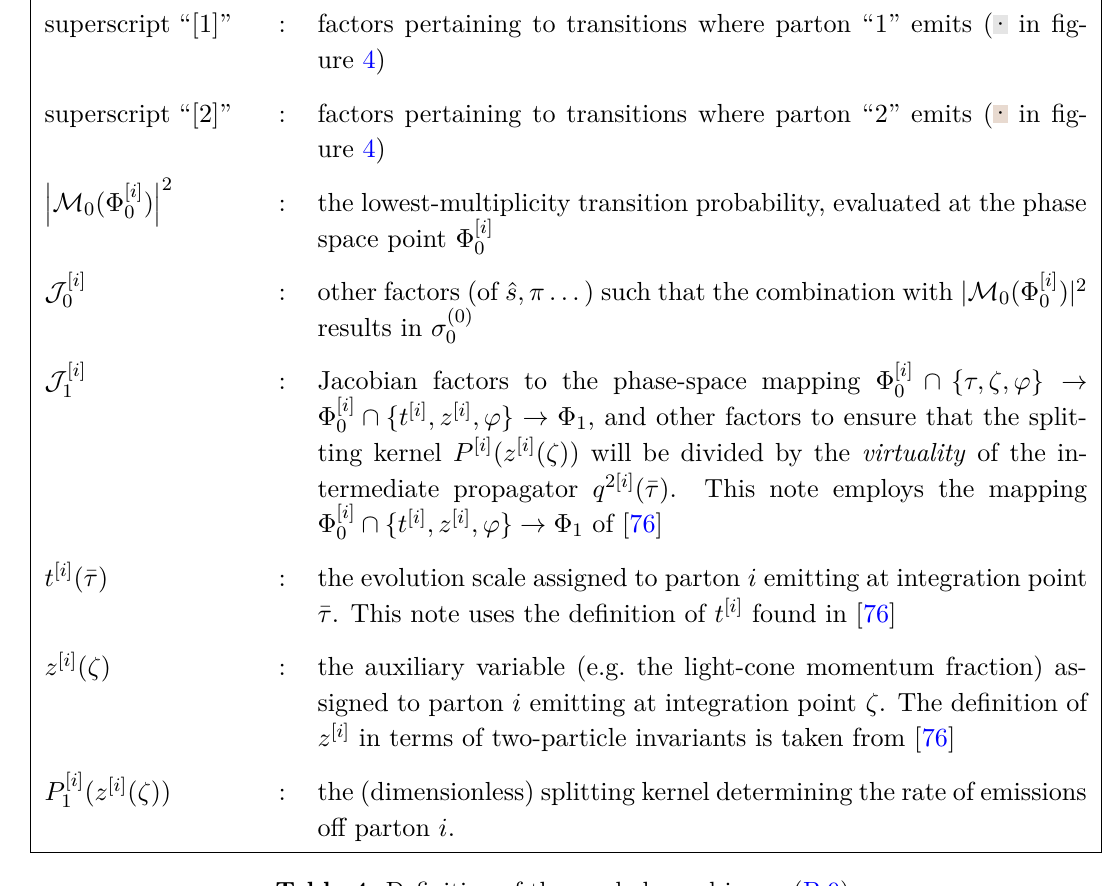
Table 4 . Definition of the symbols used in eq.